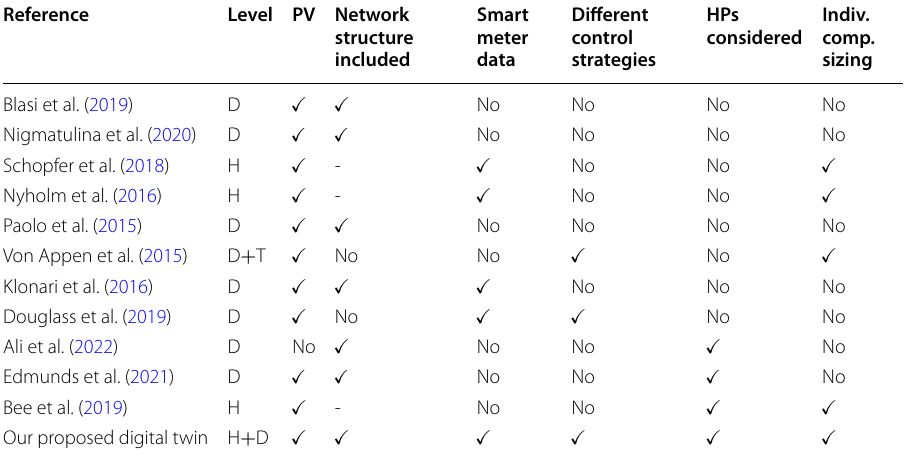
Table 1 Classification of the related work in the energy systems